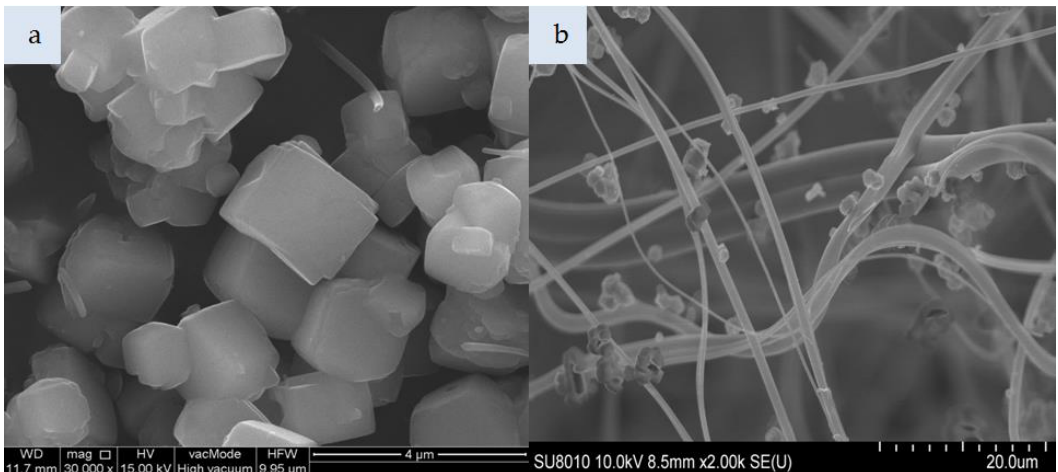
Figure 5. SEM photomicrograph: ( a ) Molecular sieve SM 4Å , ( b ) nonwoven composite with SM 4Å (magnification: a – 30.00k, b – 2.00k).